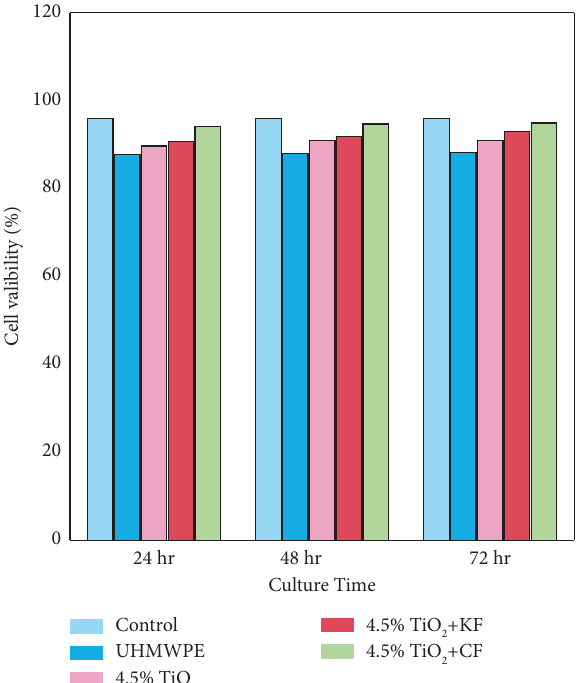
Figure 8: Cell availability of biocomposite bone plates fxation as a function of titanium dioxide